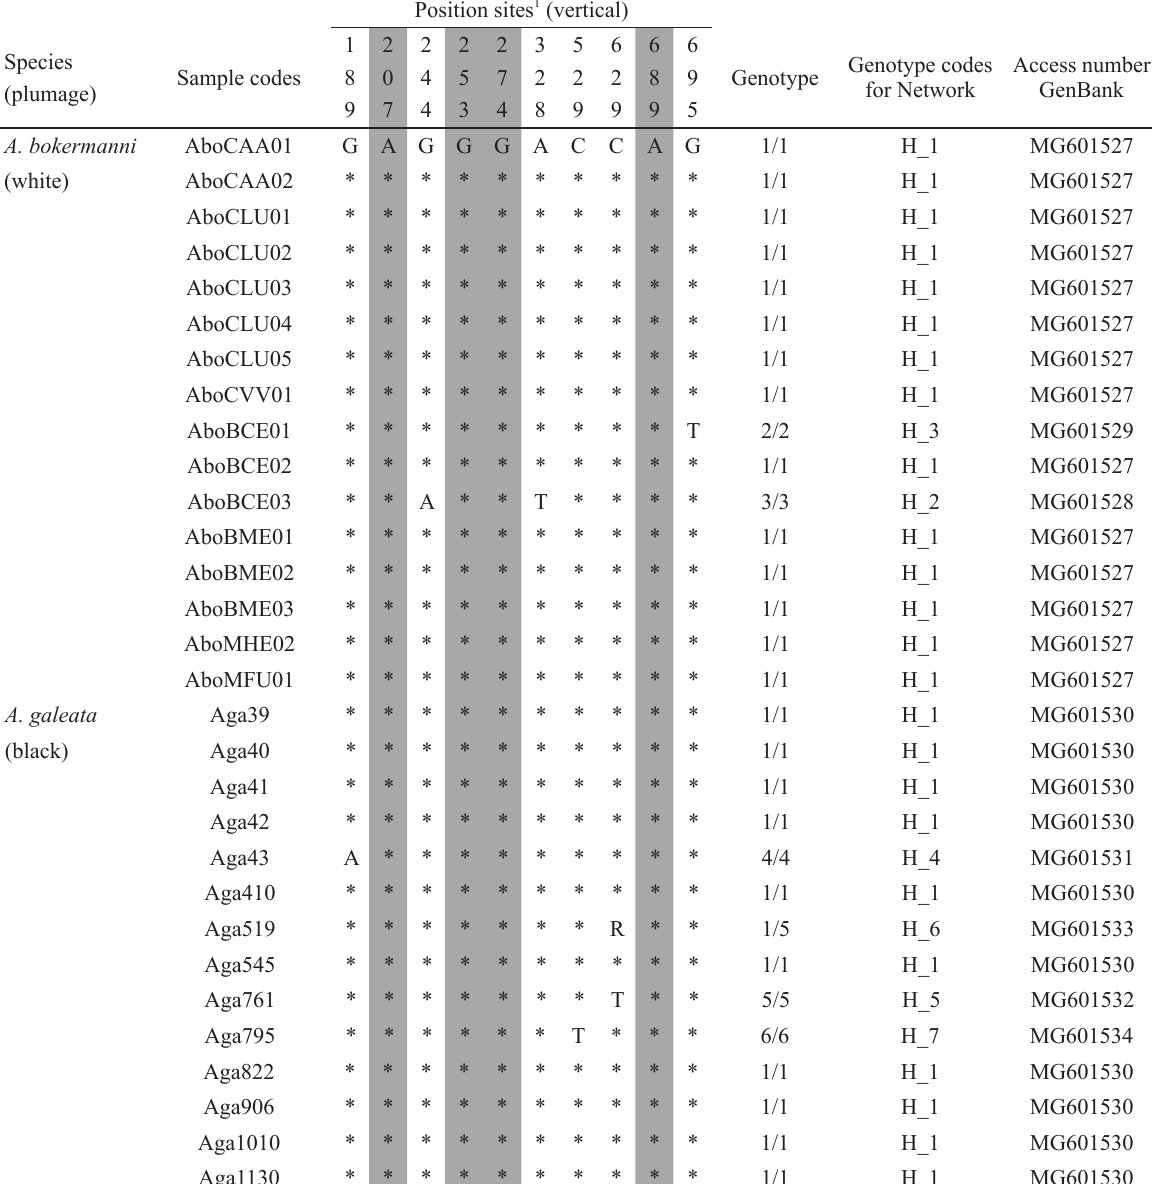
List of the species analyzed in the present study with the identification code of each specimen, the variable sites identified in the genus Antilophia and the sites (marked in gray) that have been associated with melanic phenotypes in birds. The asterisks indicate sequences equal to the initial sequence (specimen AboCAA01). Heterozygous sites are denominated by a standardized letter code established by IUPAC (R = C / T). A genotype is a combination of two alleles. Genotype codes used in the Network program. GenBank access numbers for the samples